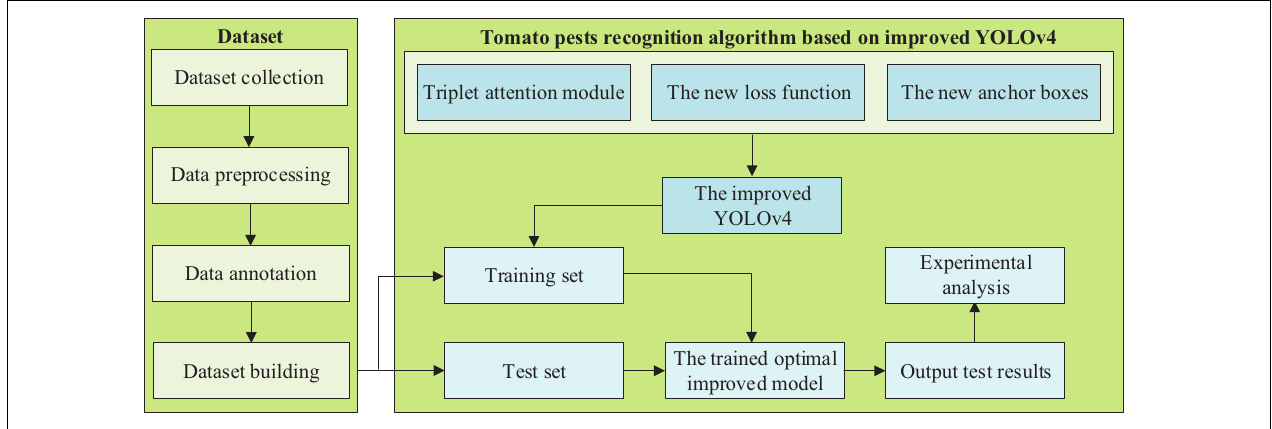
FIGURE 3 | The experimental step flow of the